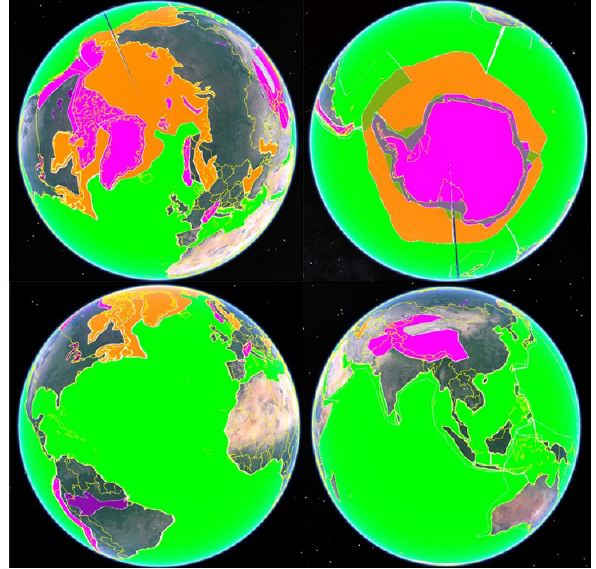
Figure 3. Indicative mission geographic operating mode mask used in CRISTAL altimeter data volume sizing. Magenta: land ice, closed-burst SARIn mode, also including smaller ice caps; orange: sea ice and icebergs, open-burst SARIn mode (maximum cover- age in Northern and Southern Hemisphere); green: open and coastal ocean, SARIn reduced window mode; purple: inland water (this is not anticipated as a mode but may be derived from one of the three key modes). Note: the wedge type feature in some of the images is an artefact of the display